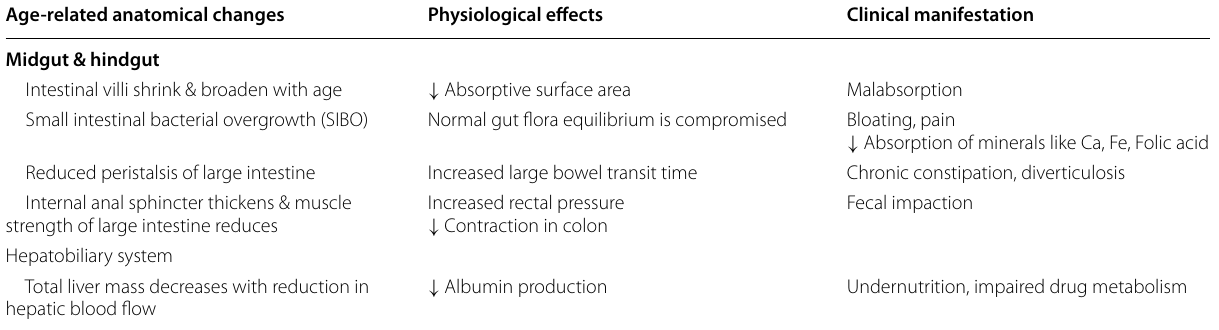
Table 2 Age related anatomical & physiological changes and their clinical manifestations Age-related anatomical